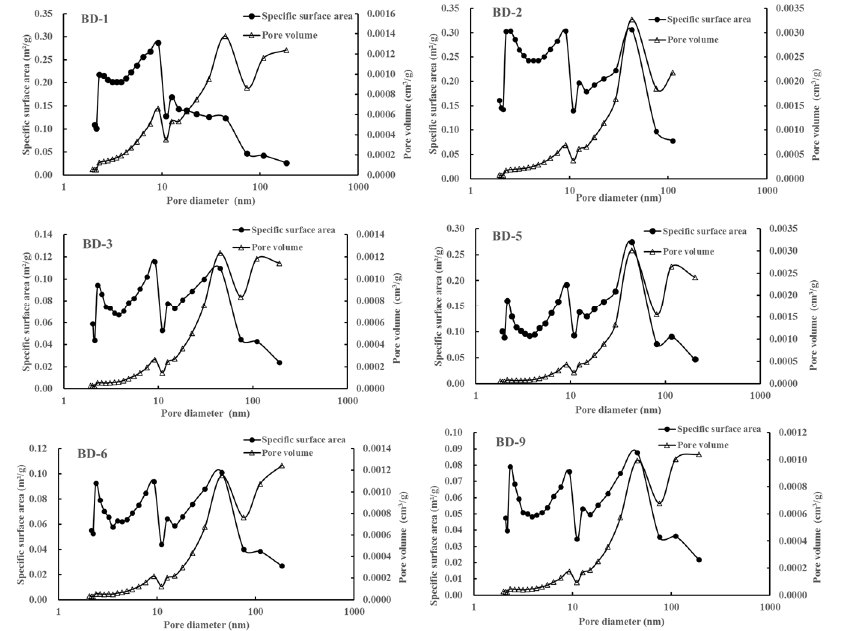
Figure 9. Relationship between pore diameter, SSA, and pore volume of typical coal samples in Baode block.